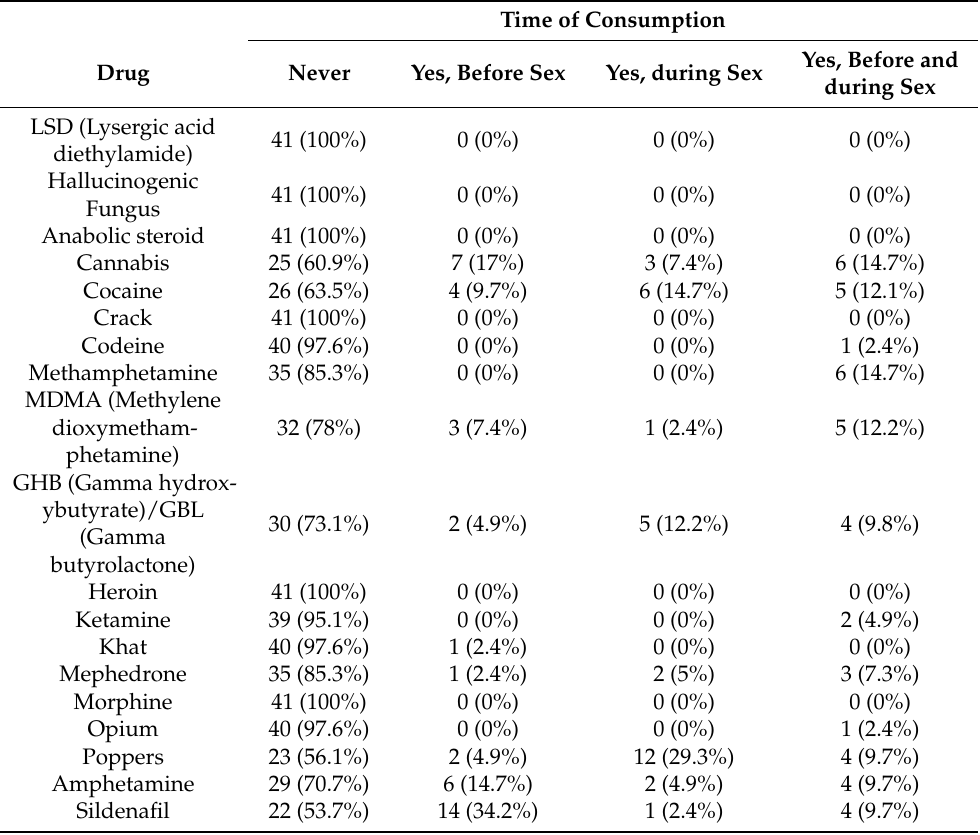
Table 2. Type of drug consumed and time of drug consumption in relation to sex. Time of